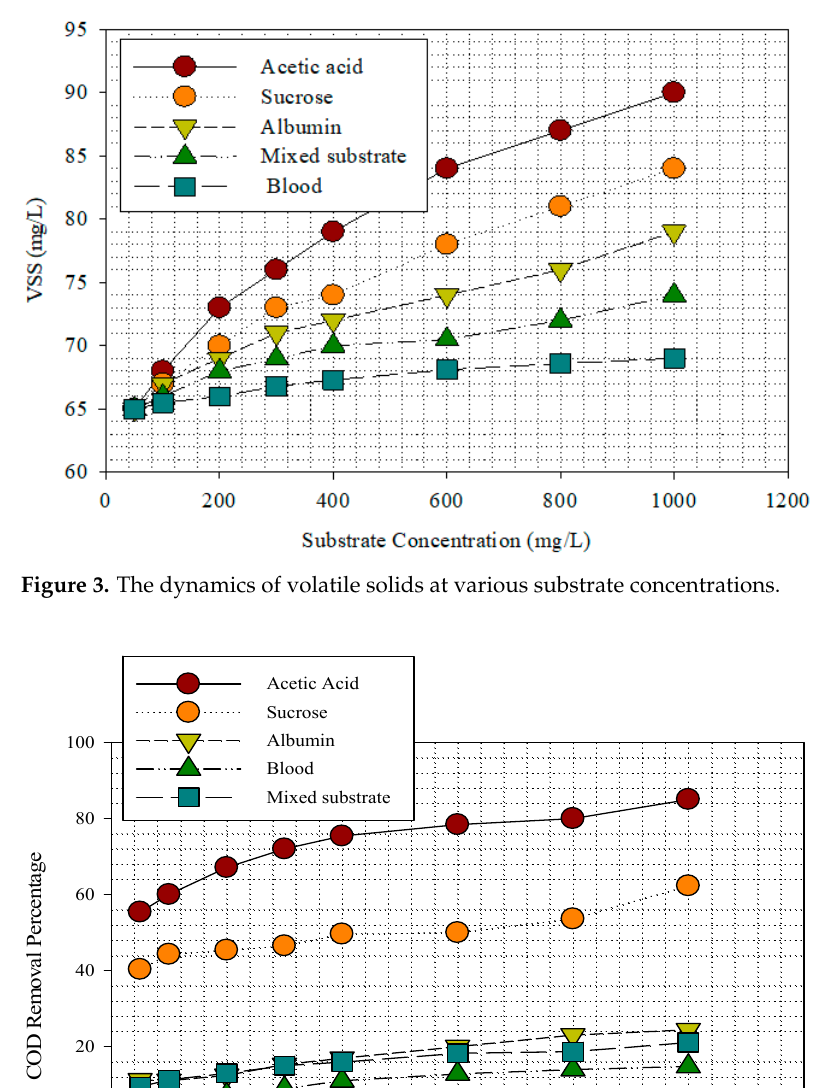
Figure 5. Columbic efficiency of various substrates used in the experiment. Coulombic efficiency indicates how many electrons (from the total electrons gener- ated by a particular substrate) are accepted in electricity generation by the MFC after a particular time. The complexity of the substrates seemed to exert an impact on Coulombic efficiency. Acetic acid contains two carbon atoms—it is a carbon-neutral source that must be hydrolyzed by electrogenic bacteria in order to generate electrons [23]. Sucrose (a 22- carbon compound) is a disaccharide that needs hydrolysis before it can be used by micro- organisms, while many microbial species may uptake sucrose for assimilatory metabolism as well. Albumin is a protein with 123 carbon atoms, which indicates the complexity of albumin in comparison to acetic acid [24]. Blood also contains proteins—namely, the heme protein—which makes its degradation more difficult.